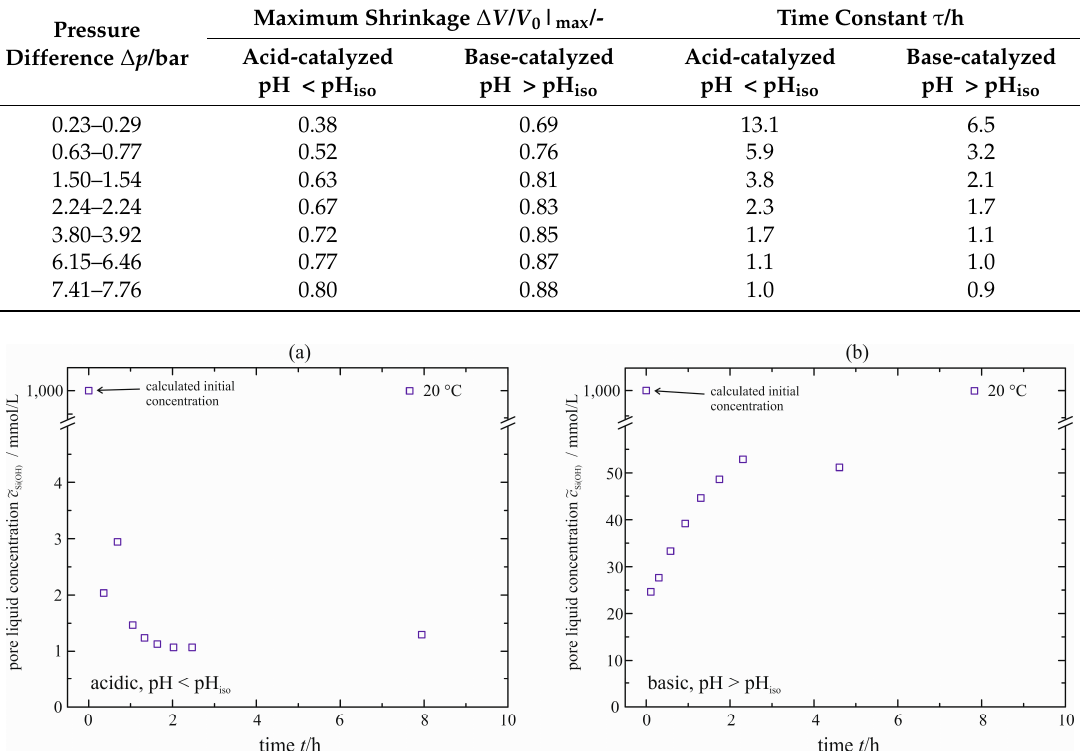
Table 3. Maximum shrinkage Δ V / V 0 | max and characteristic time constant τ , enforced syneresis, s 0 = 16 mm and ϑ = 20 °C.